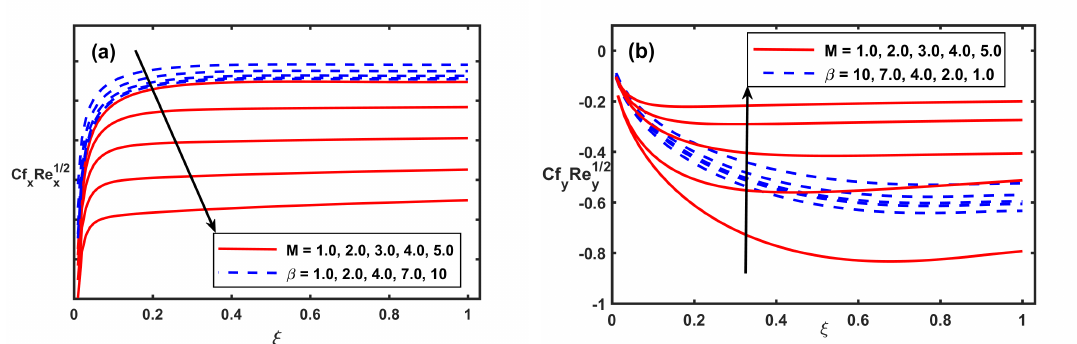
Figure 10. Fluctuation of Cf x Re 1/2 x and Cf y Re 1/2 y along with M and β